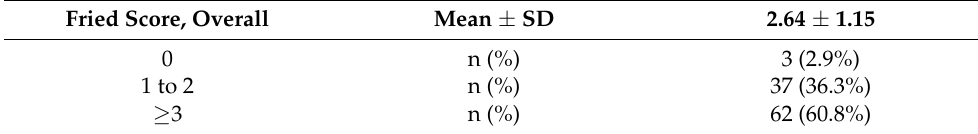
Table 3. Fried scale results in current population (n = 102).